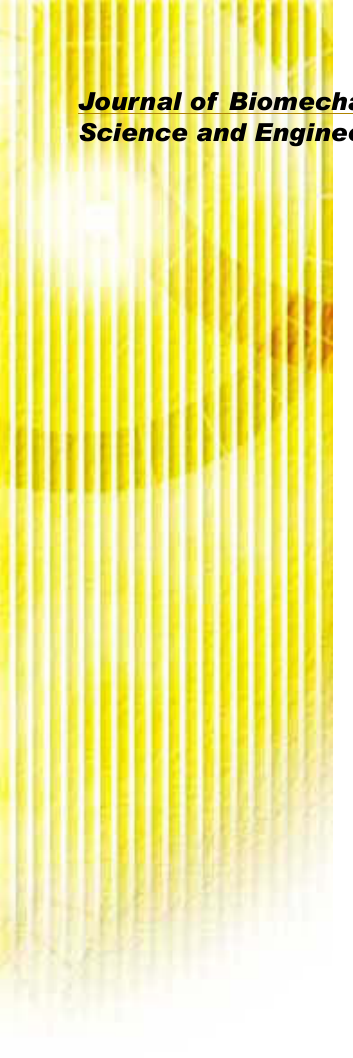
Fig. 14 Average Recognition Rate of Five Table 3 Braille Recognition Time by VF and VD